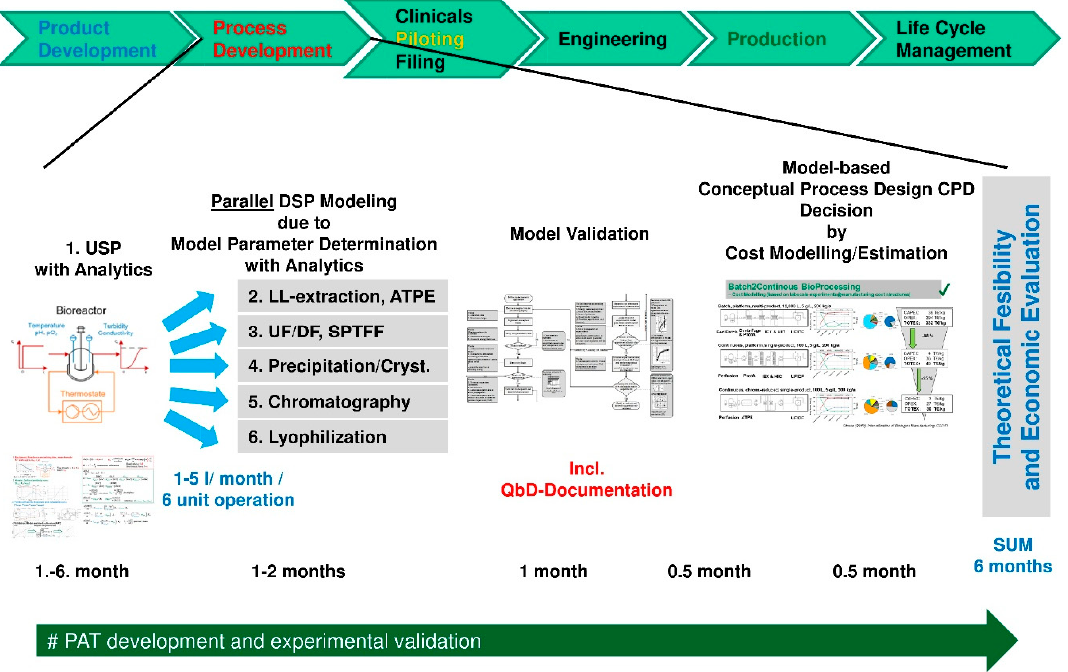
Figure 12 Figure 12. Efficient process development and design with aid of process